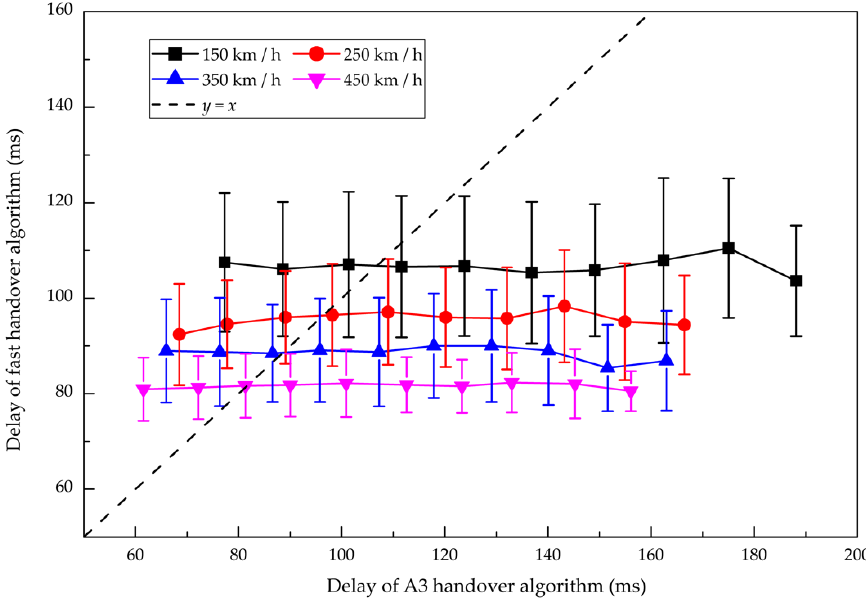
Figure 15. Comparison of the delays of the handover between the fast handover algorithm and the A3 handover algorithm. Marks represent the bin averages of different handover delay intervals, and bars correspond to the standard deviation in each bin.